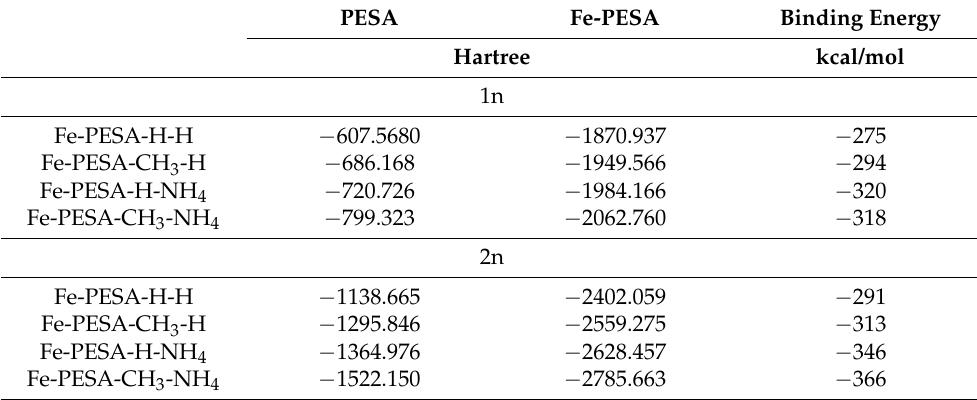
Table 2. The energies of the optimized molecules with the calculated binding energy, according to Equation (1). The energy of Fe II is − 1262.9 Hartree.